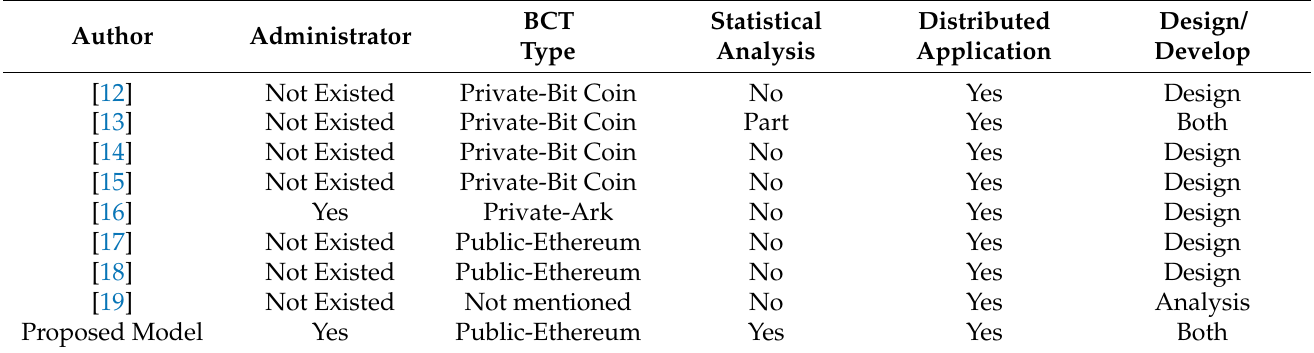
Table 1. Literature Survey